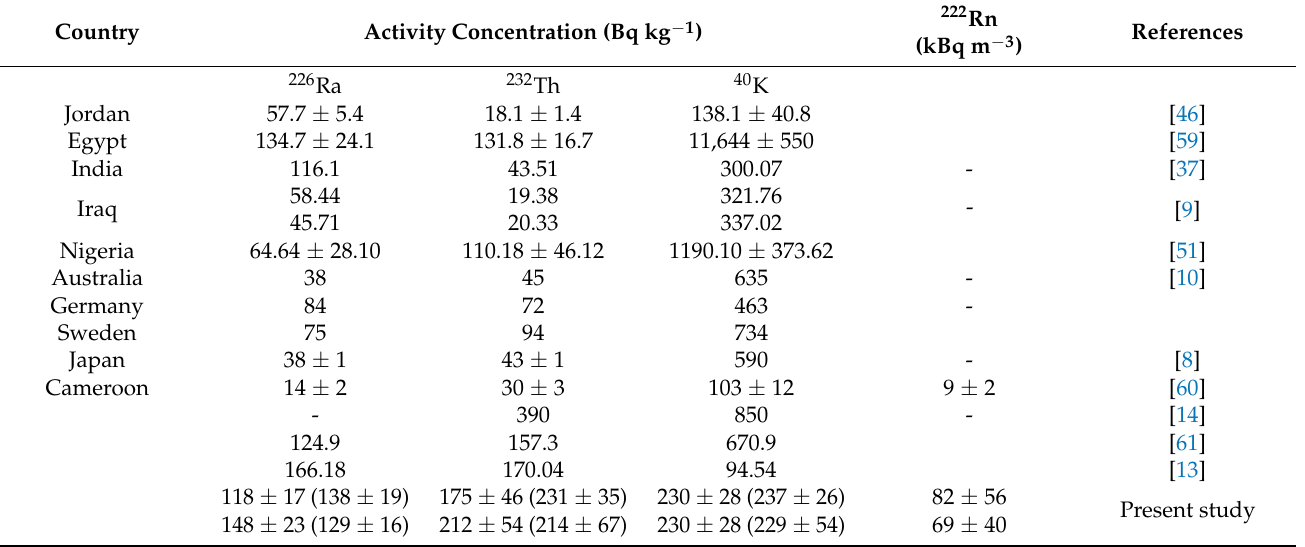
Table 3. Comparison of 226 Ra, 232 Th, 40 K, and 222 Rn activity concentration with other